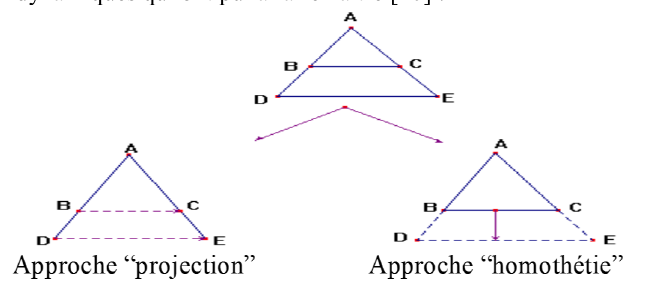
Fig. 1. Figure « triangle ».